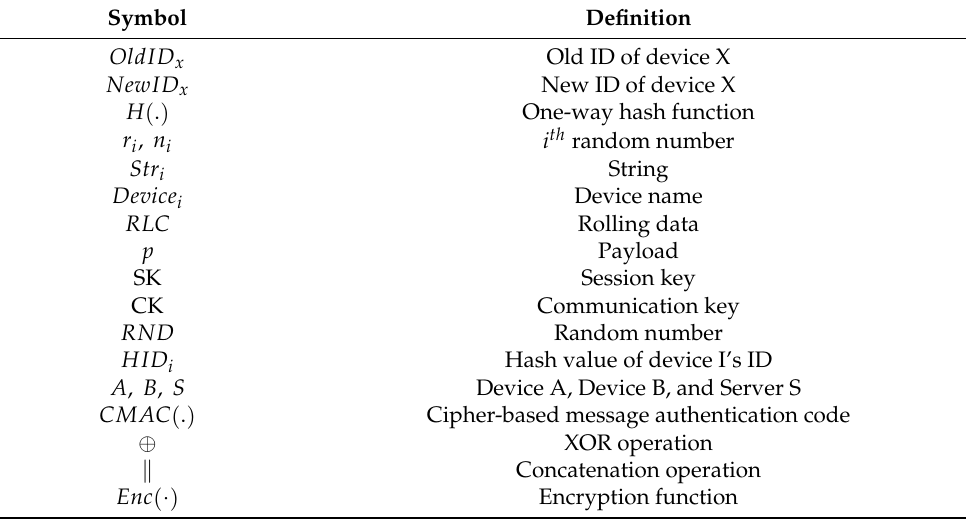
Table 6. Symbolic representation of EnOcean-A communication